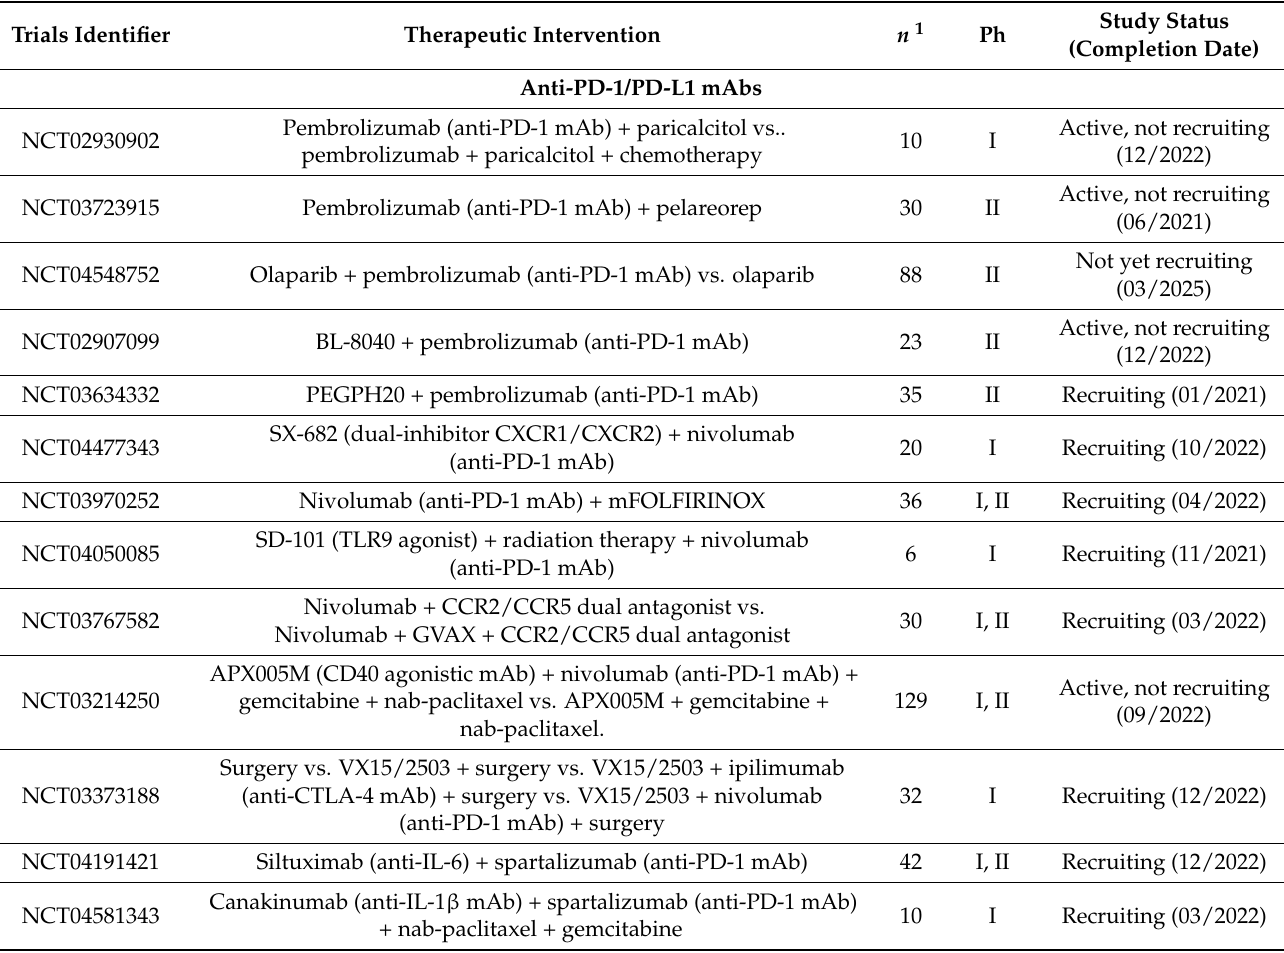
Table 6. Selected ongoing clinical trials evaluating monoclonal antibodies alone or in combination with other drugs in pancreatic cancer (www.clinicaltrials.gov accessed on 17 March